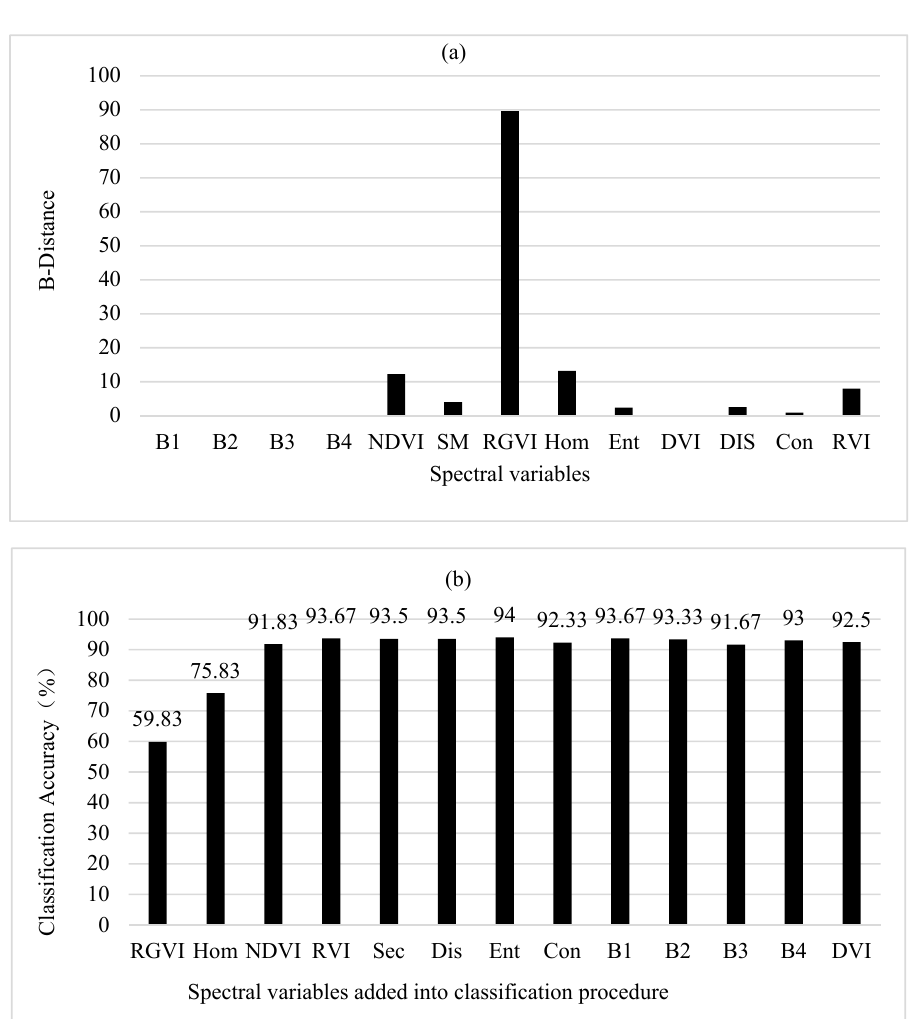
Figure 6. ( a ) Potential class separability of six land cover types for each spectral variable (Note: the values of B1, B2, B3, B4 and DVI were 0.04, 0.03, 0.01, 0.01 and 0.01, respectively and could not be shown because of too small values); and ( b ) the classification accuracies of Bayesian discriminant ( BD ) classifier as the spectral variables were added based on average B-distances.